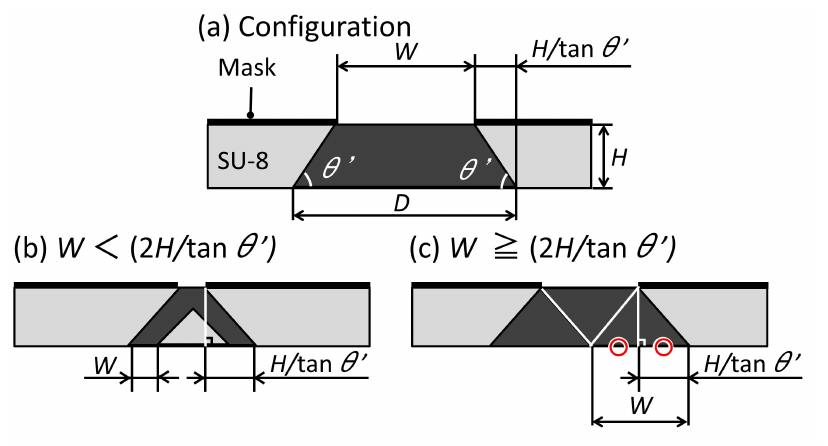
Figure 3. Schematic illustration of the inclined lithography for making a trapezoid-shaped cross-section.